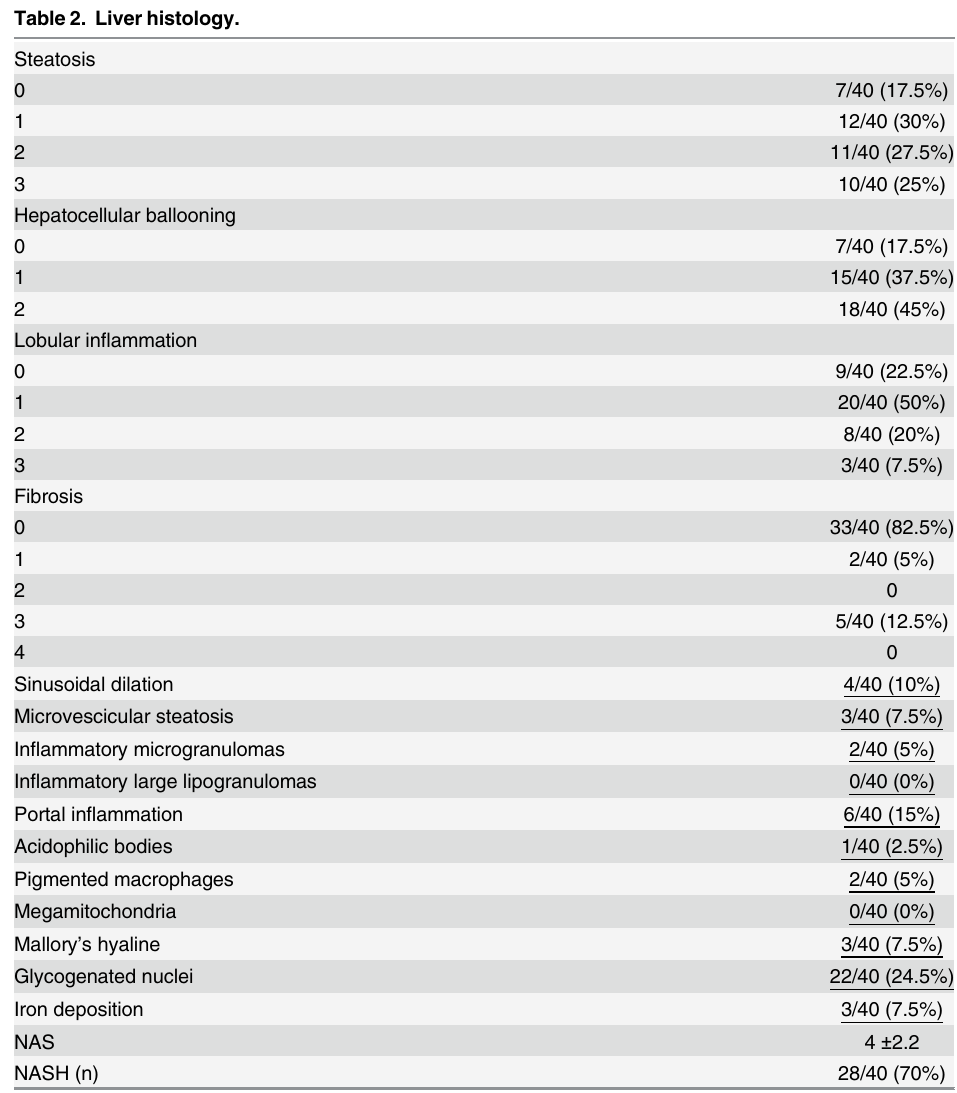
Table 2. Liver histology.